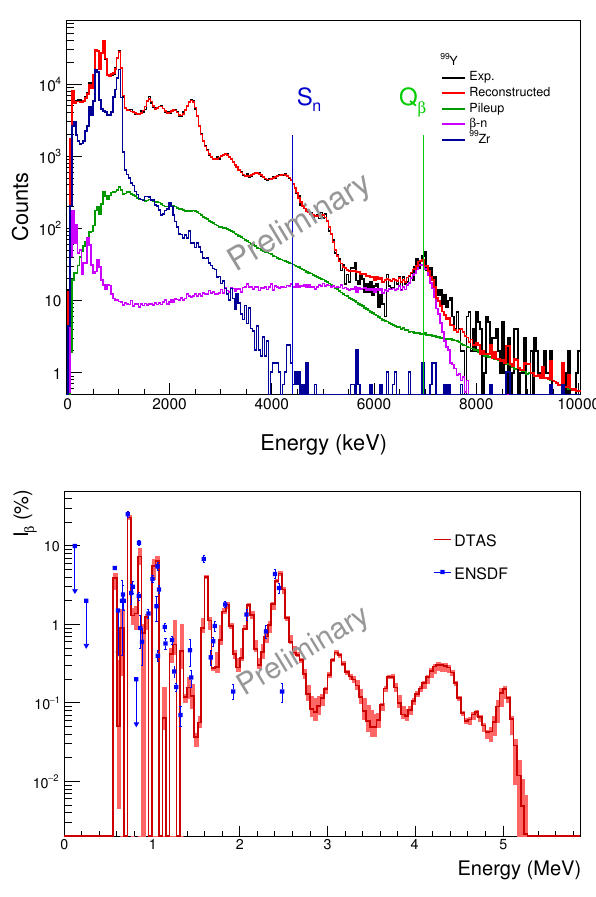
Figure 1. Top: Experimental TAS spectrum of 99 Y showing also contaminants (see text) and the recon- struction obtained after the application of the Bayes method (red line). Bottom: Beta intensity of the beta decay of 99 Y (see